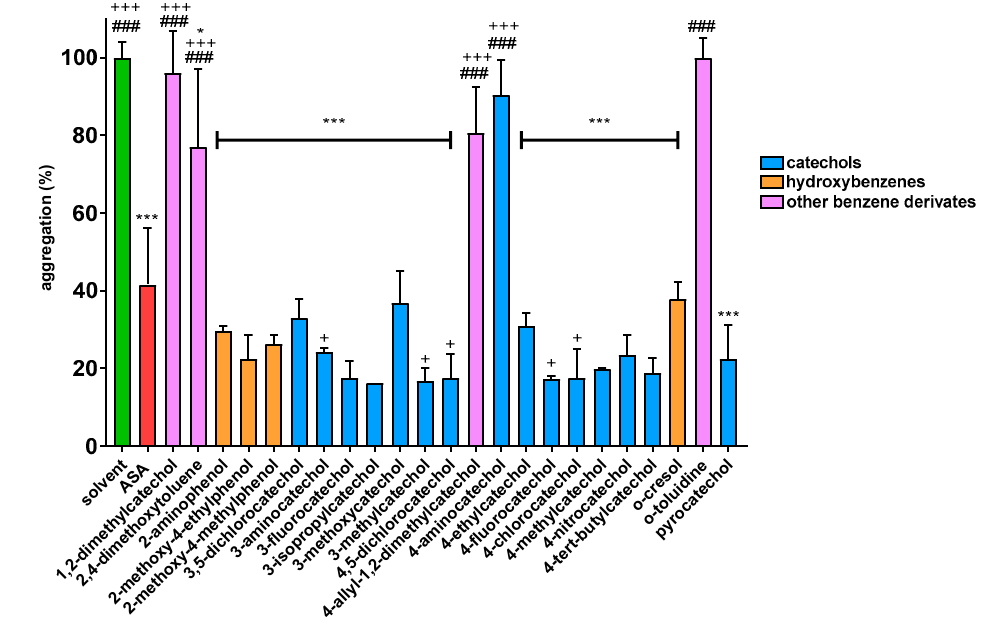
Figure 1. Effect of Phenolic Compounds on AA-induced Aggregation: Results are presented as means with ±SD. * p ˂ 0.05 vs. DMSO; *** p ˂ 0.001 vs. DMSO; + p ˂ 0.05 vs. ASA; +++ p ˂ 0.001 vs. ASA; ### p ˂ 0.001 vs. 4-methylcatechol.